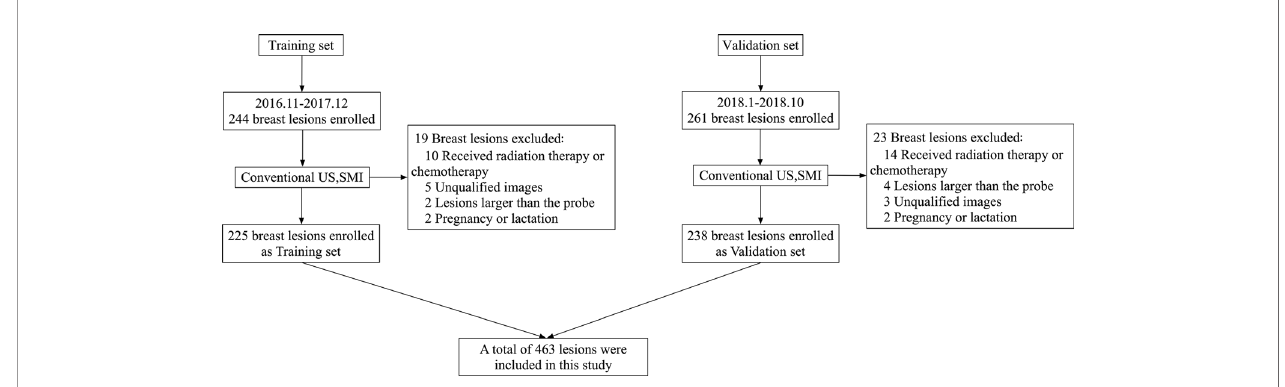
FIGURE 1 | Flow chart of patients enrolment in the training set and veri fi cation